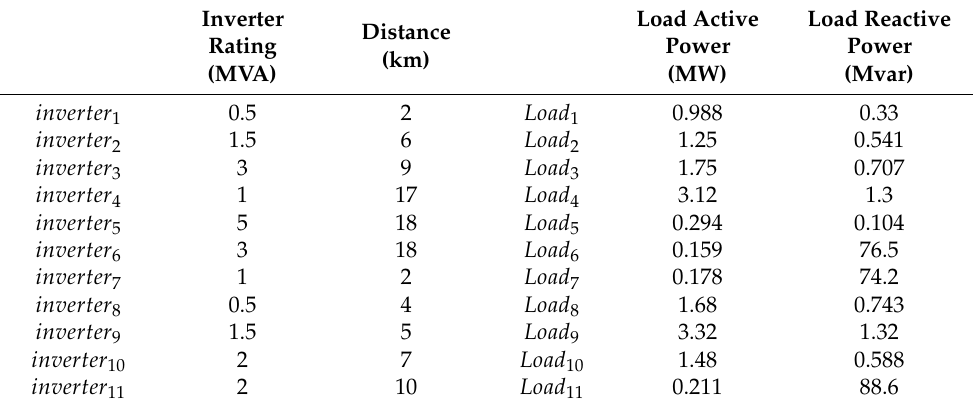
Table 2. Virtual STATCOM Simulation Model Parameters.